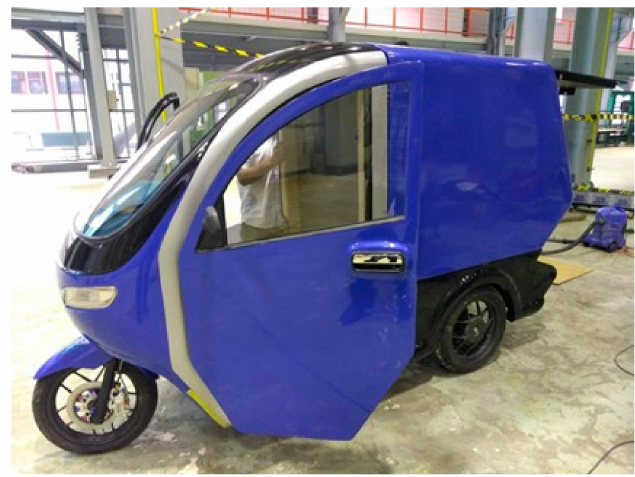
Figure 1. Electric trike as a goods delivery vehicle.